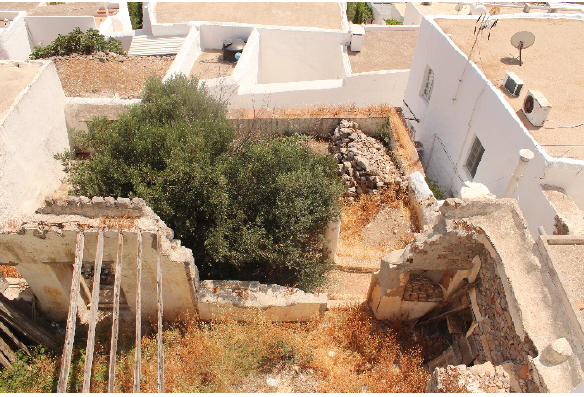
Figure 13. A ruined house inside